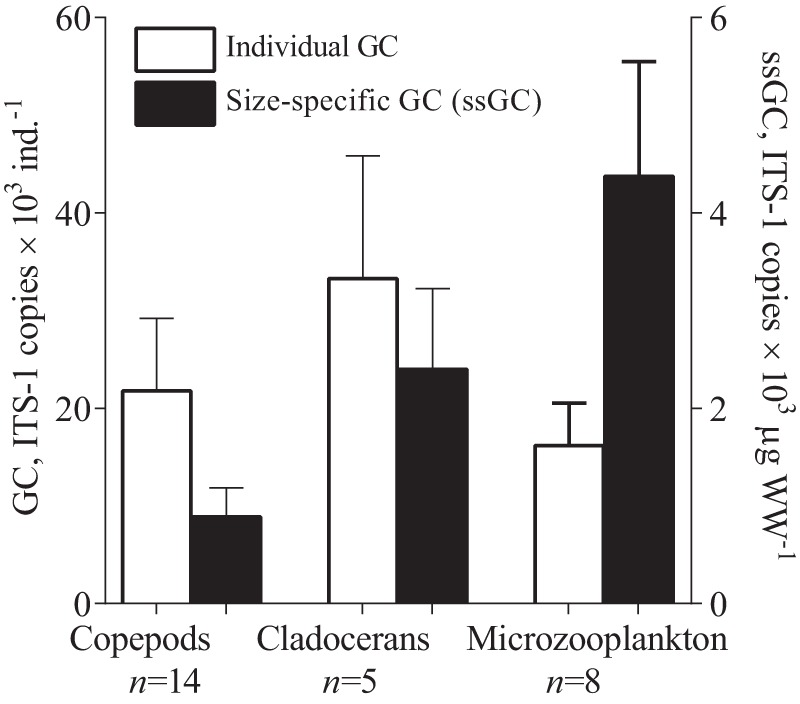
Occurrence of Synechococcus spp. in field-collected zooplankton.Individual gut content (GC; prey ITS-1 copies ×103 ind−1) and size-specific gut content (ssGC; prey ITS-1 copies ×103 µgWW−1) in main zooplankton groups: copepods (adults and older copepodites of Acartia spp. and Eurytemora affinis), cladocerans (Bosmina maritima and Podon spp.) and microzooplankton (rotifers Synchaeta spp., Keratella quadrata, and K. cochlearis, and copepod nauplii). Data are shown as mean ± SD, number of samples is given below the group name.